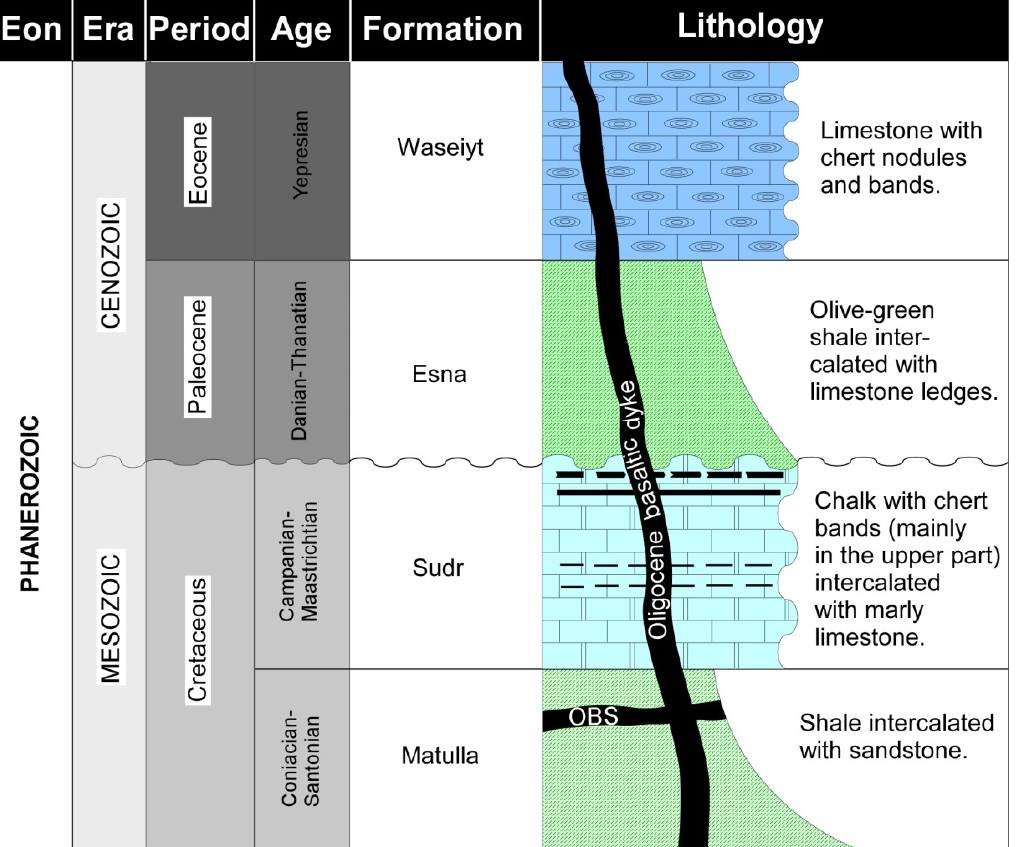
Figure 5. A generalized lithostratigraphic section of the study area. (OBS: Oligocene basaltic sill).